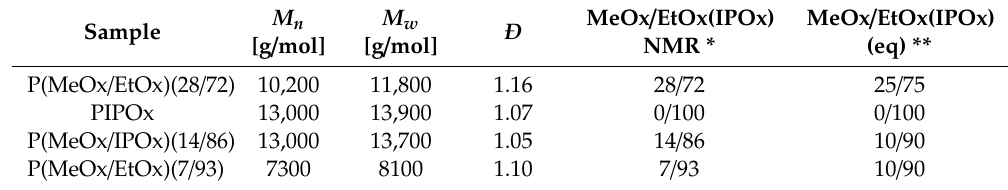
Table 1. Molecular characteristics of the IPOx homopolymer and block